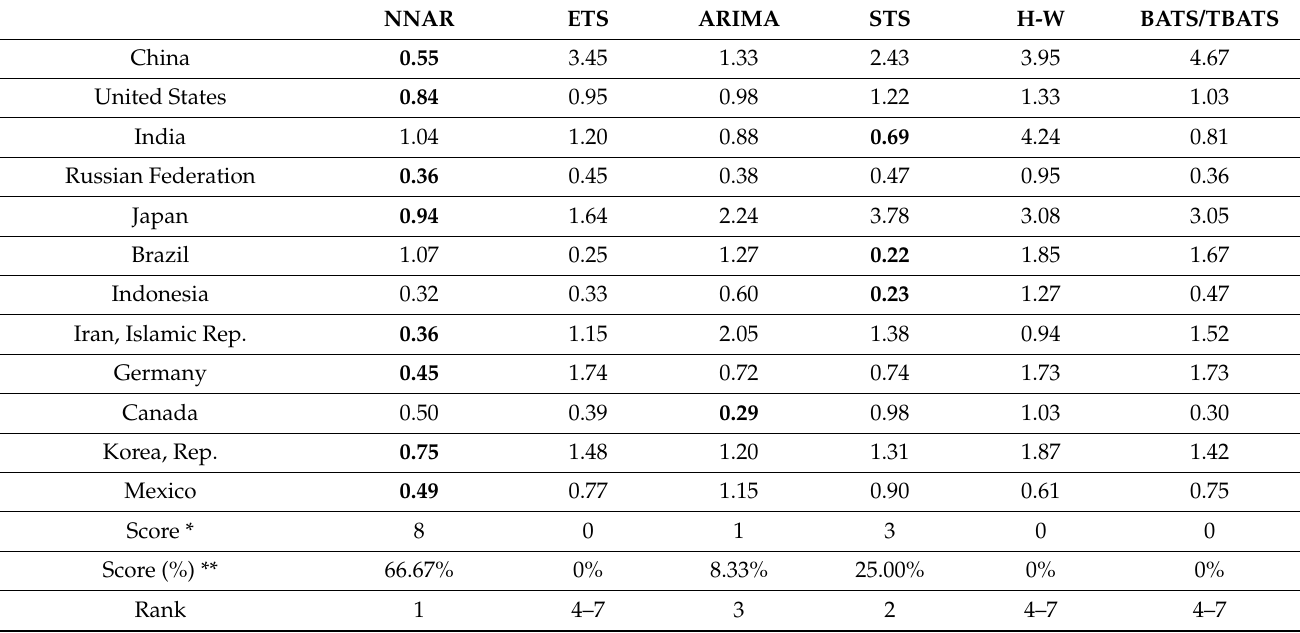
Table A2. Forecasting Accuracy (MASE for Out-of-Sample Forecasting at h =